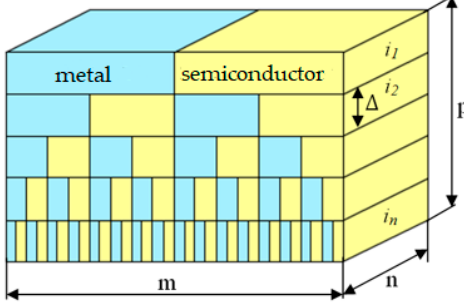
Figure 7. Reflective screen lattice element.